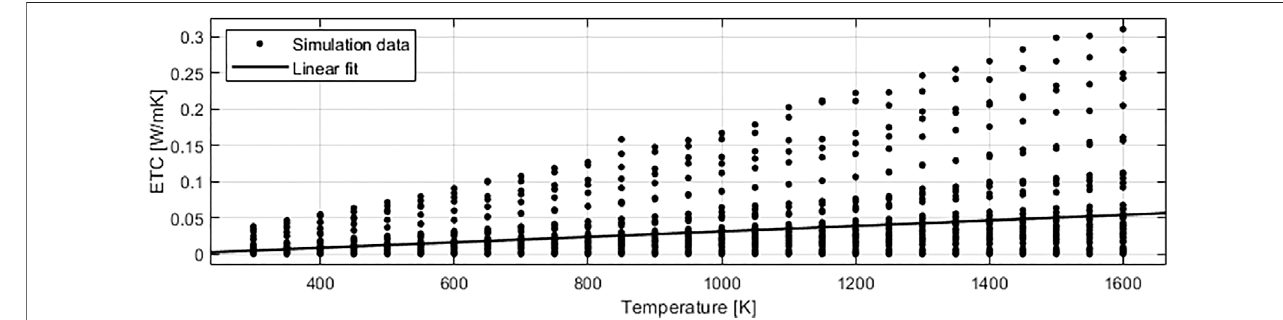
FIGURE 8 | ETC data from simulation.